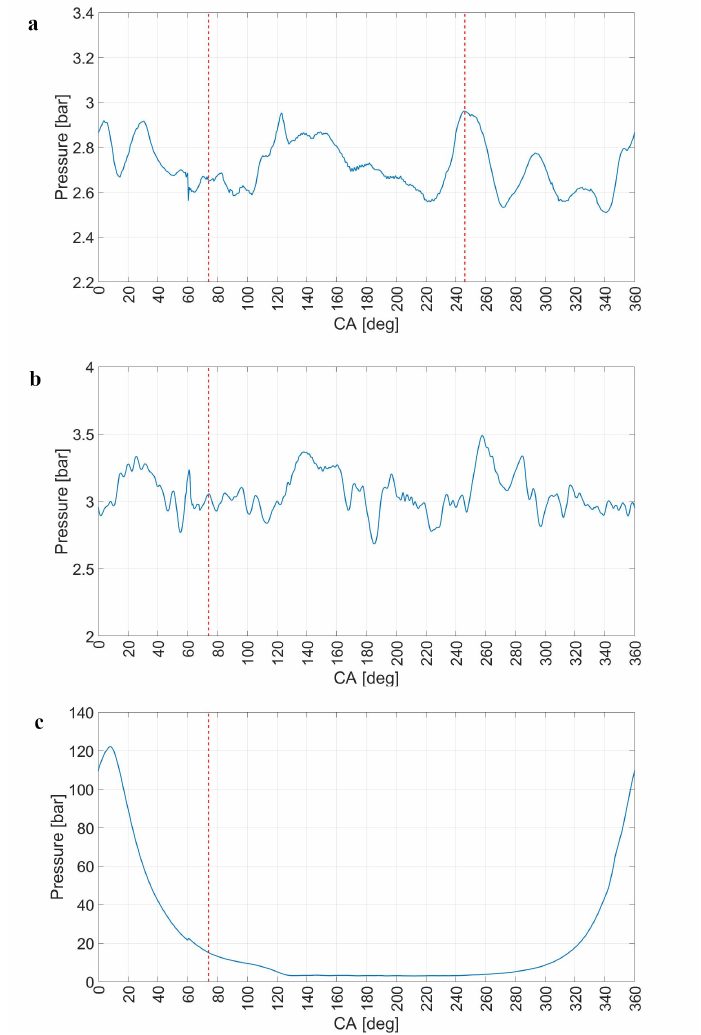
Figure 6. Measured pressure at the exhaust section ( a ), in the plenum ( b ), and in the cylinder ( c ) as a function of the crank angle. Red dashed lines represent the start and the end of the simulation. Based on the results of 1-D simulations, the initial fluid temperature is set as follows for each region: 443 K for the plenum, 861 K for the exhaust pipes, and 1250 K for the engine chamber, as given in Figure 7a. Finally, the engine and exhaust pipes are initially filled by Burned Gas , while the plenum is filled by Fresh Air (see Figure